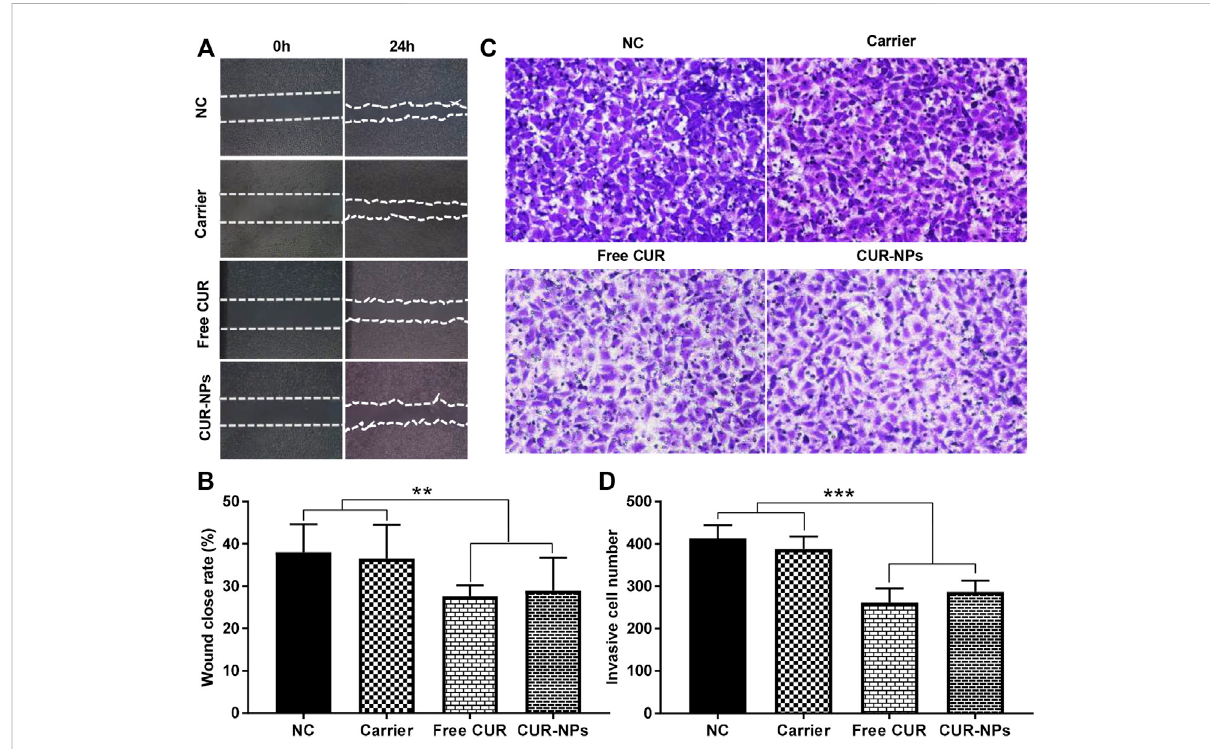
FIGURE 9 Free CUR and CUR-NPs suppress the migration and invasion of MDA-MB-231 cells. (A,B) A wound-healing assay was performed to investigate themigrationofMDA-MB-231cells after beingtreatedwith freeCUR,CUR-NPs, orcarrier. (C,D) Theinvasion abilities ofMDA-MB-231 werestudied bythetranswellassayaftercellsweretreatedwithfreeCUR,CUR-NPs,orcarrier.NC,treatedwithnegativecontrol;carrier,treatedwiththecarrierof PEG 5k -b-PLLA 5k ; CUR, treated with free CUR; CUR-NPs, treated with CUR-loaded PEG 5k -b-PLLA 5k nanoparticles. ** p < 0.01, *** p < 0.001.